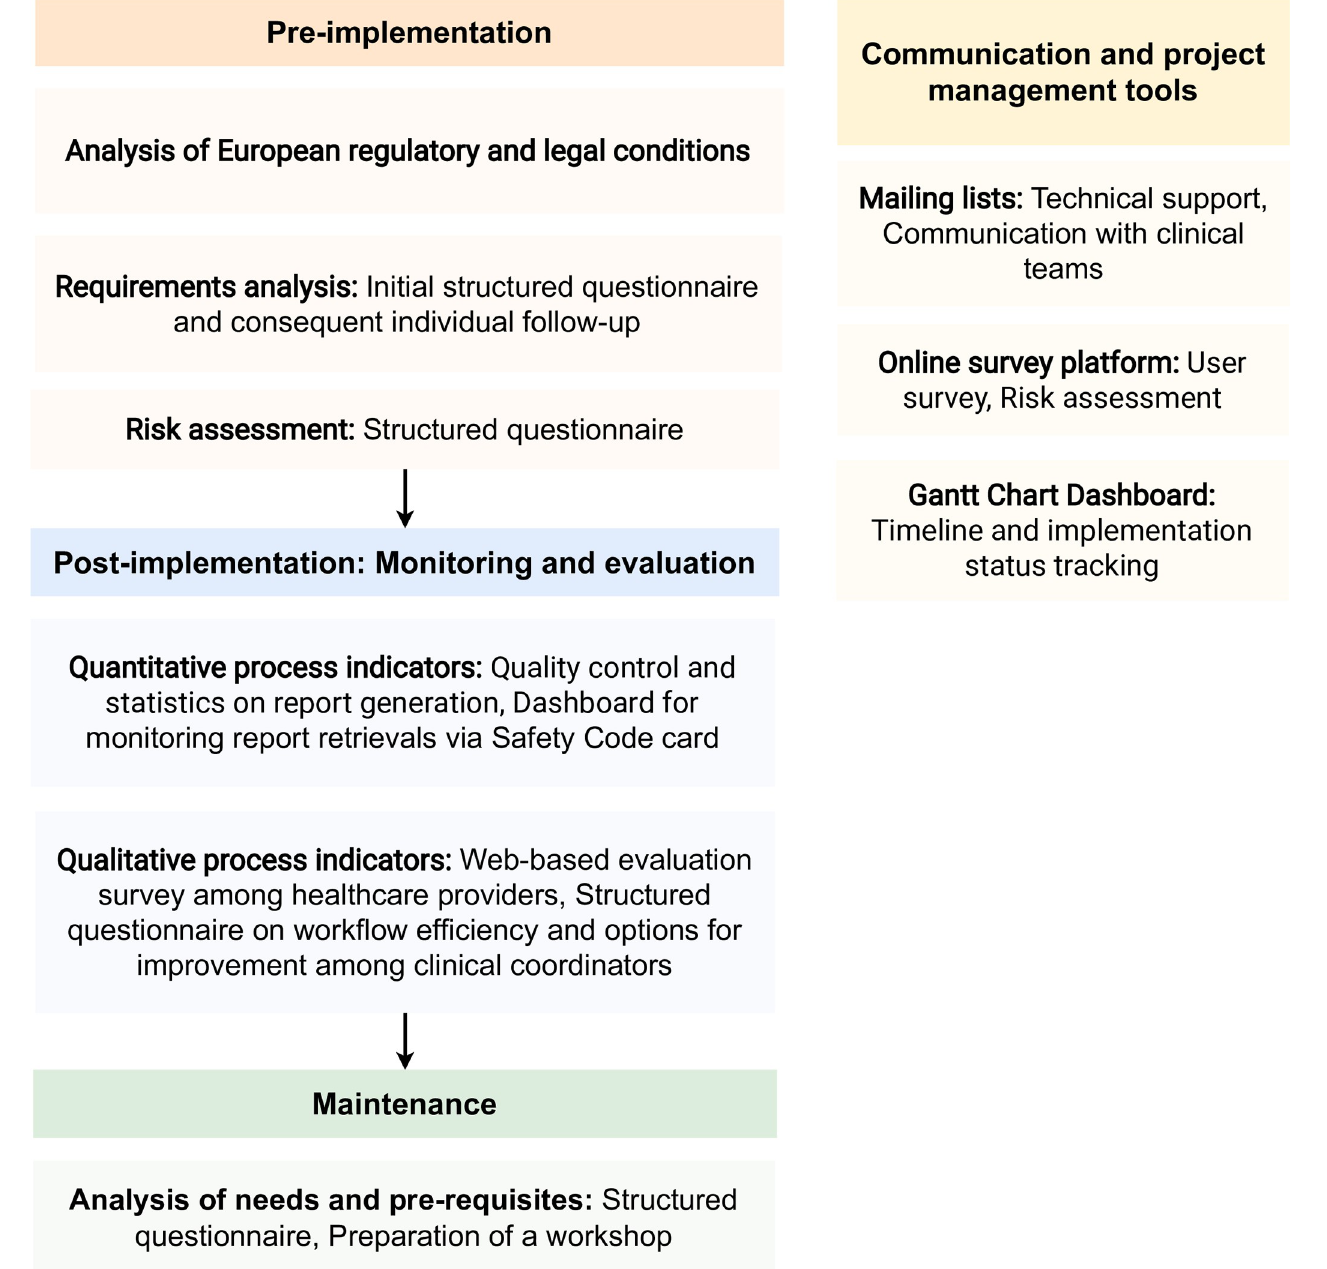
Fig 3. Phases and tools of the implementation